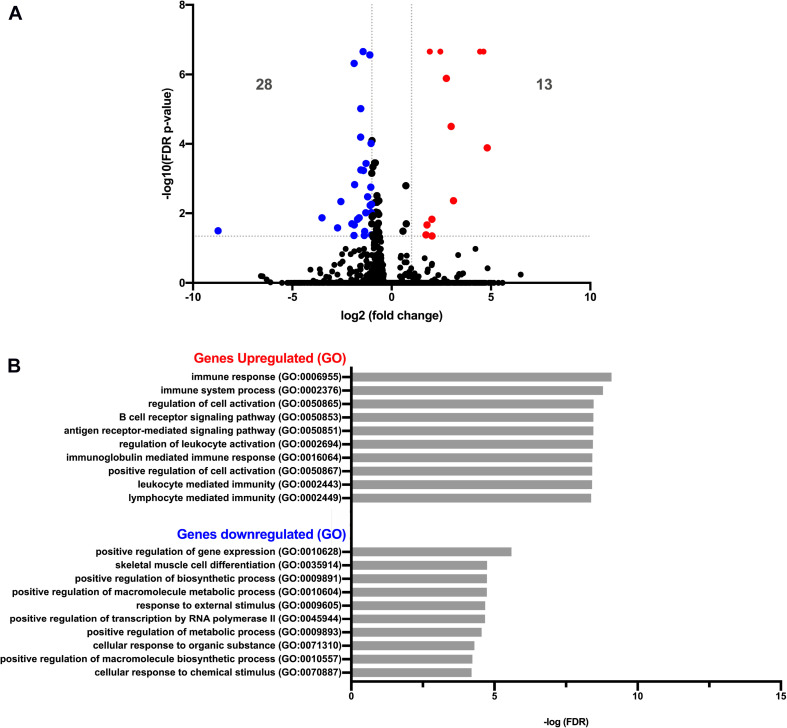
Gene expression analysis of pancreatic cancer EV-treated bone marrow cells. (A) Volcano plot of RNA-Seq of PBS versus EV-treated CD11b+ BM cells showing 13 and 28 genes significantly up- and downregulated (red dots and blue dots, respectively), with FDR P-value ≤ 0.05 and fold change > 2 or < −2. (B) Graph plot of the most significant processes of Gene Ontology (GO) enrichment analysis in the “Biological Process” section of up- and downregulated genes, using the Gene Ontology PANTHER Database.